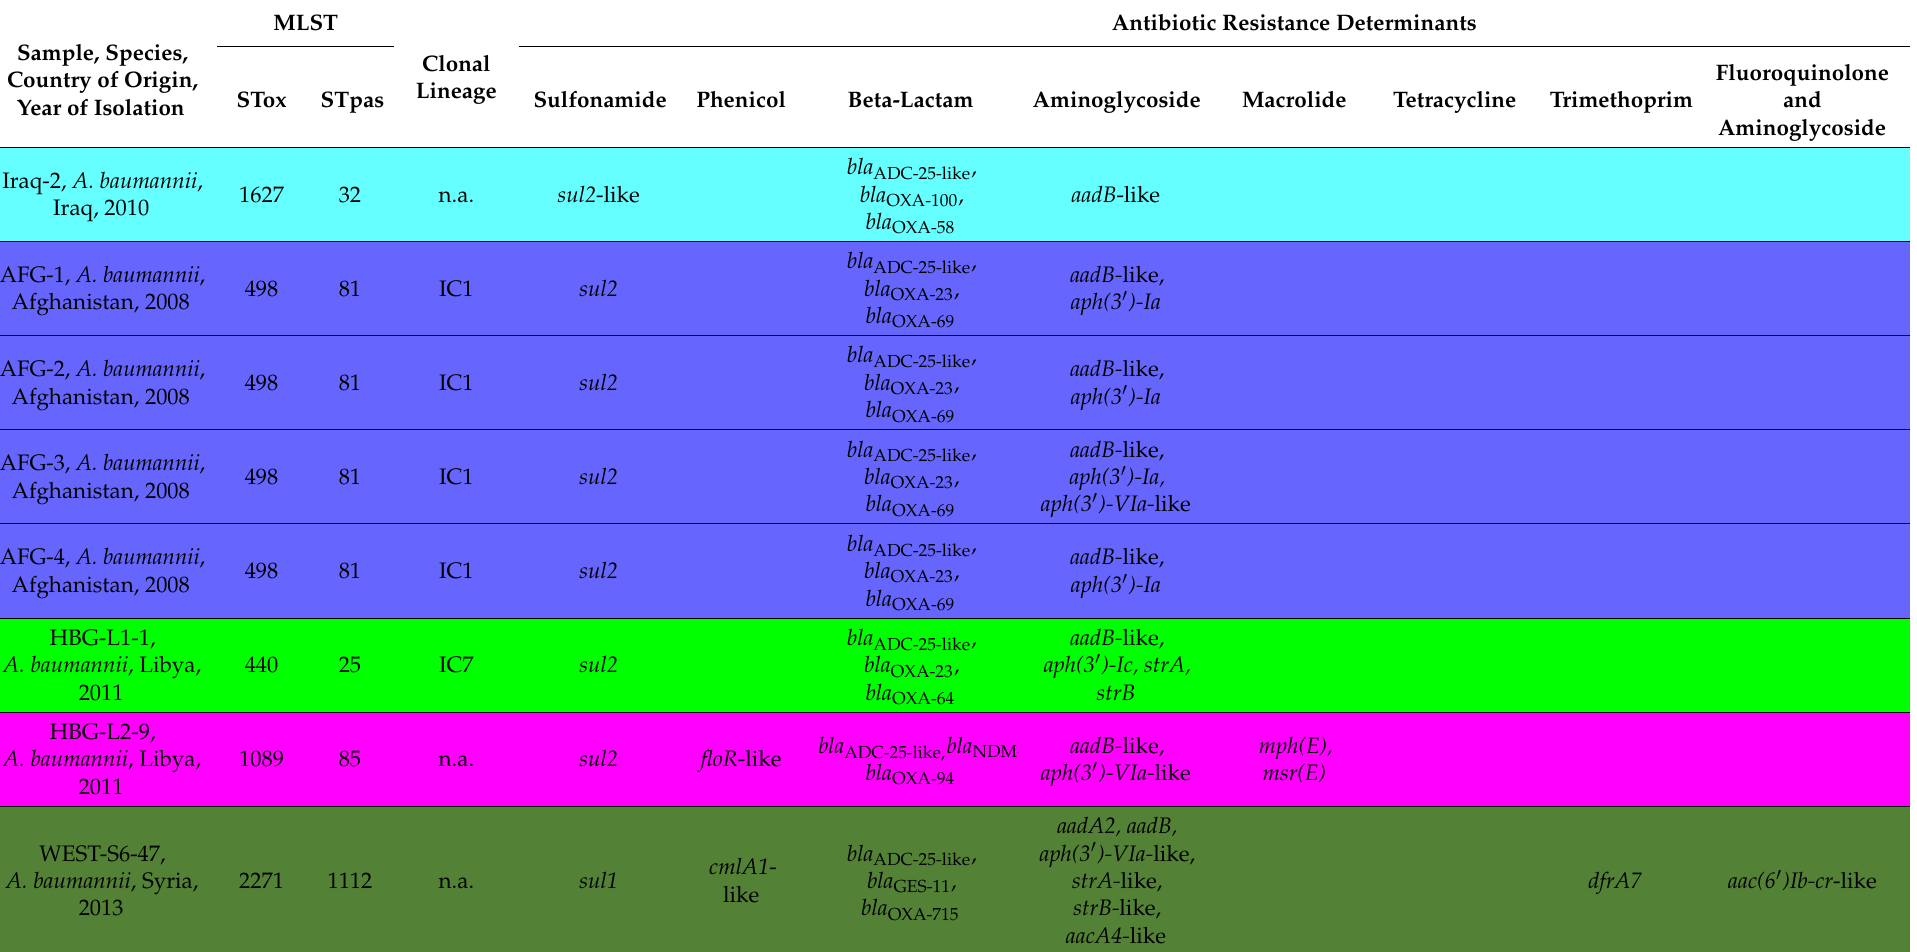
Table 1. Analysis of antimicrobial resistance determinants, ordered by strain, MLST type, and the international clonal lineage of the assessed Acinetobacter spp. isolates. N.a. = not applicable, ST = Sequence type, IC = International clone. Clusters are indicated in the same colors as in Figure 1.